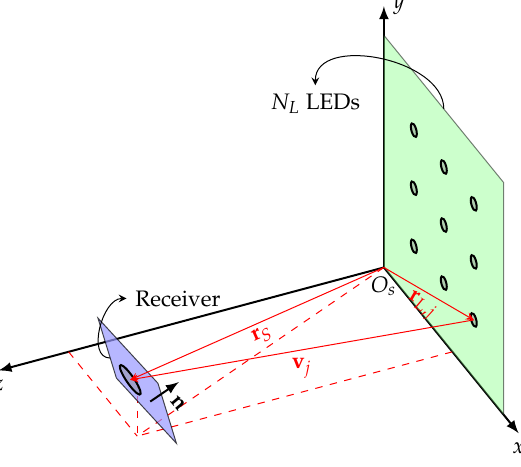
Figure 4. System frame for